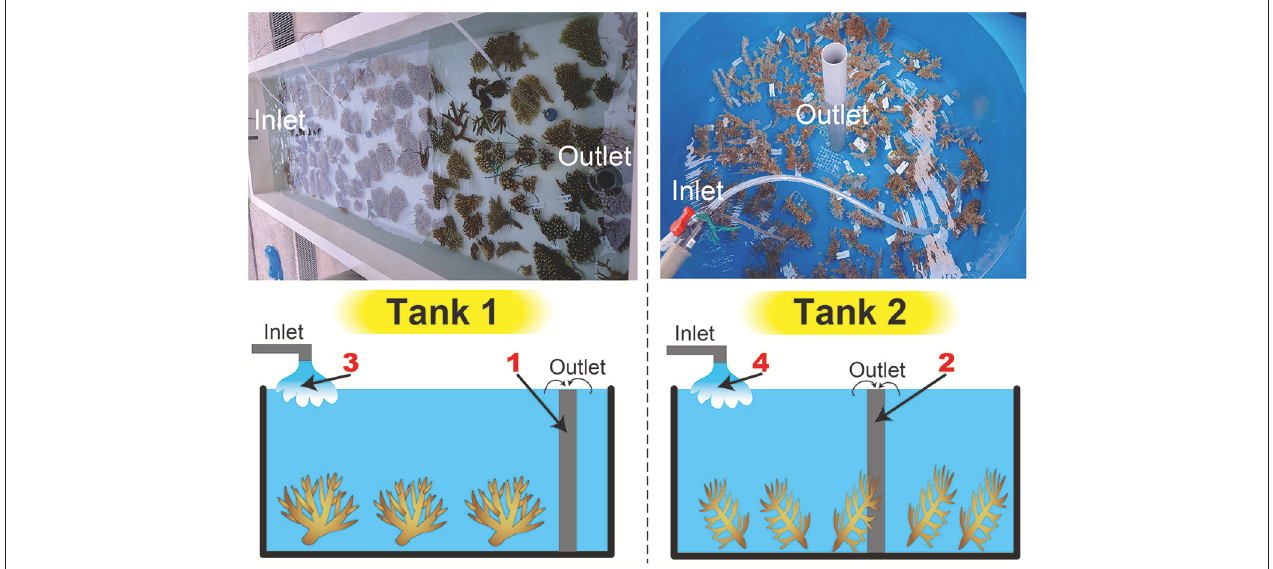
FIGURE 1 | Tanks used in this study and a schematic drawing of water sampling. Photographs of the tanks are shown above, and a schematic drawing of water sampling is shown below. We filtered seawater from inlets and outlets in both tanks (four sample numbers in